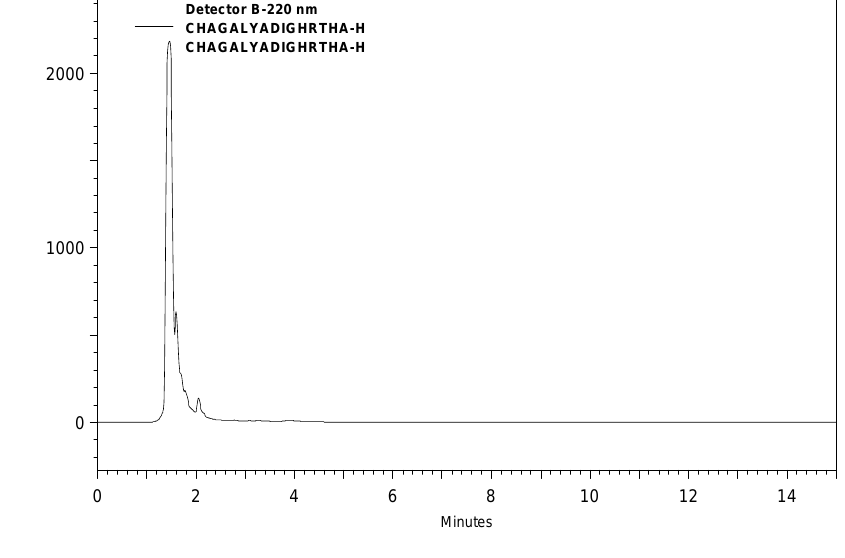
FIGURE 4FIGURE 4. HPLC CHROMATOGRAM OF PHALA